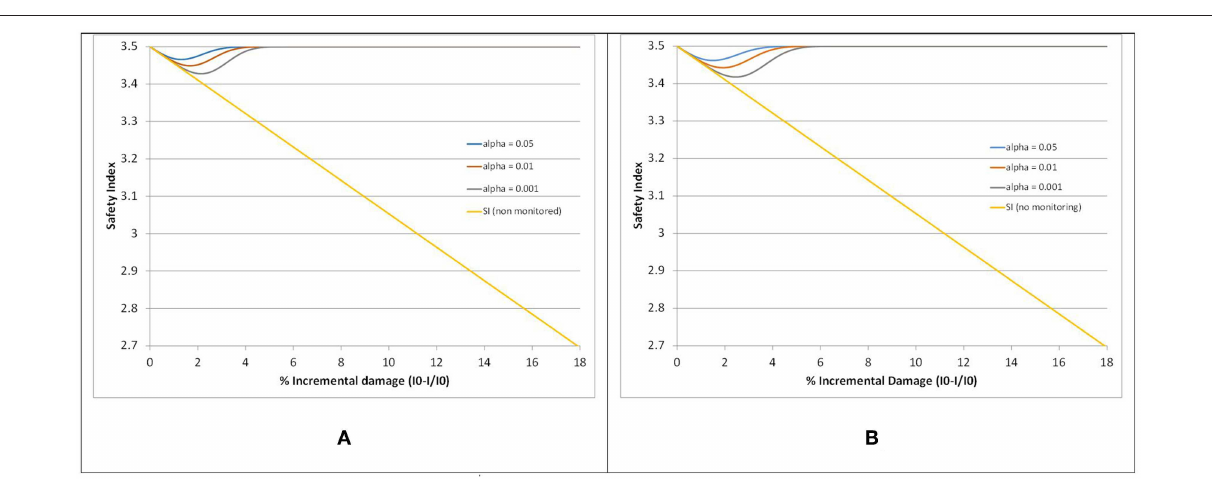
FIGURE 13 | Safety Index as a function of damage level and monitoring based on changes in wavelet coefficients for damage located at (A) 0.17L and (B) at